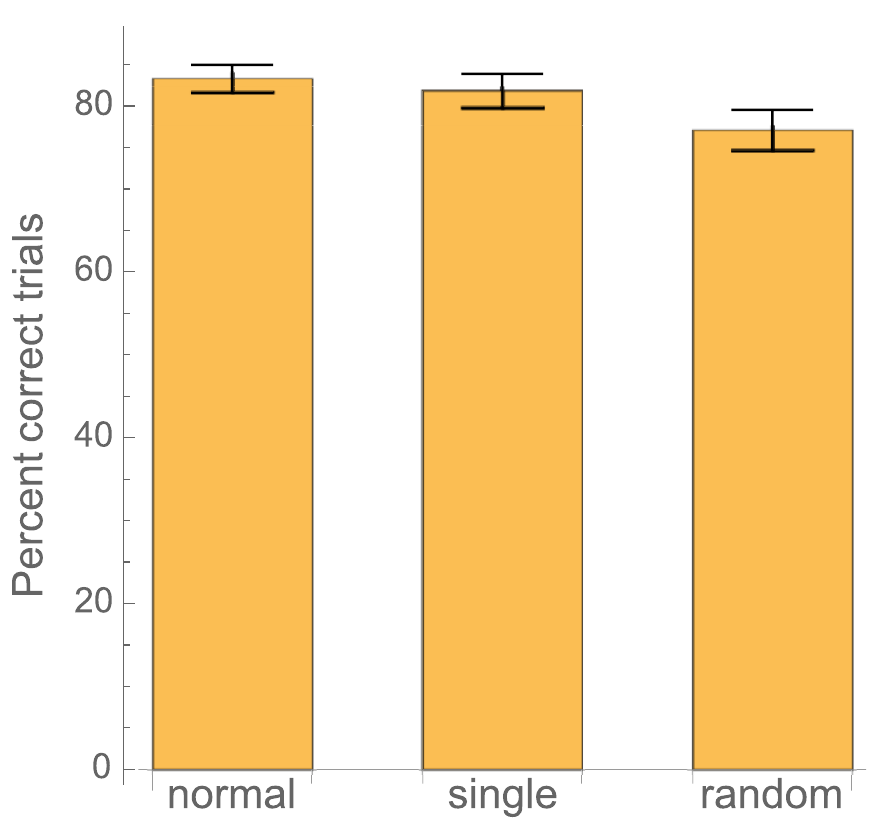
Fig 2. The percentage of correctly played sequences: Subjects made significantly more mistakes when feedback was not predictable.